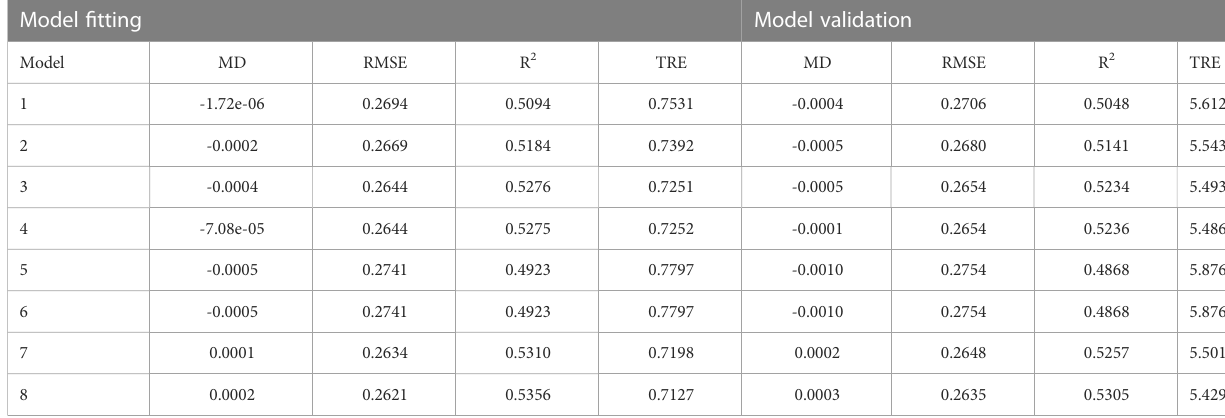
TABLE 4 Fit indicators of the basic models ( Table 3 ). Model fi tting Model